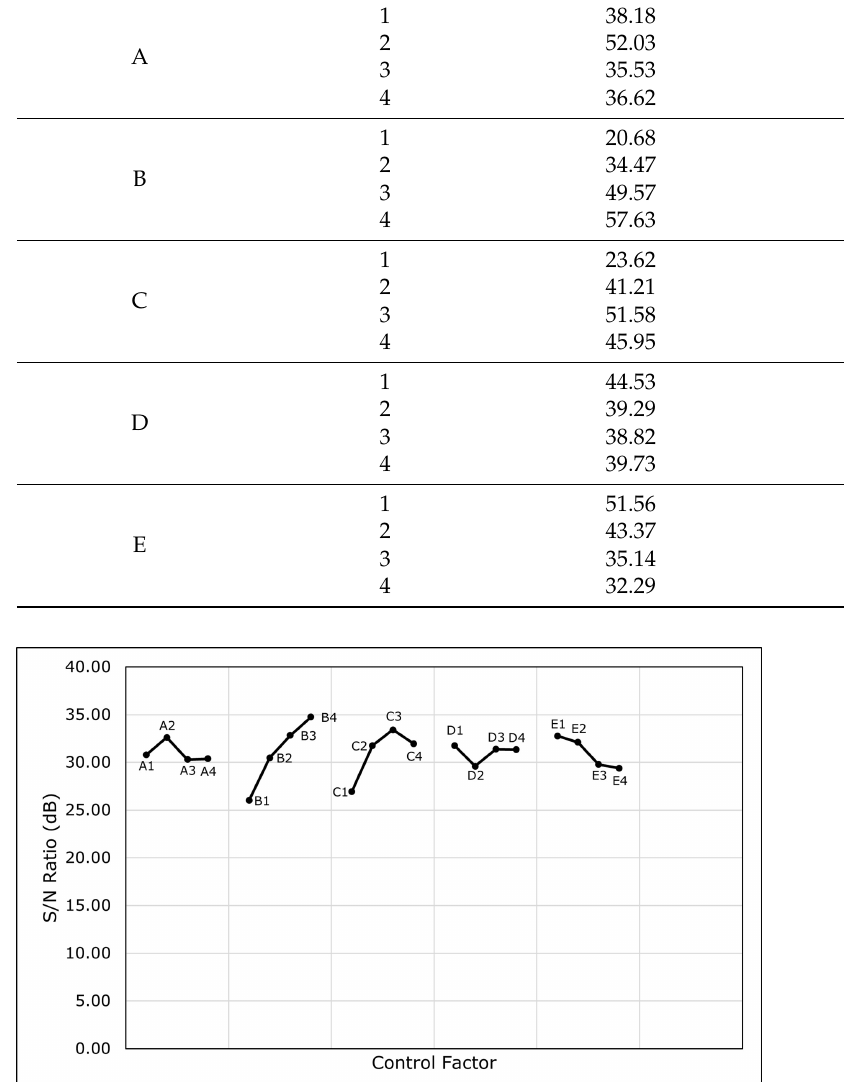
Figure 8. Response Chart: S/N